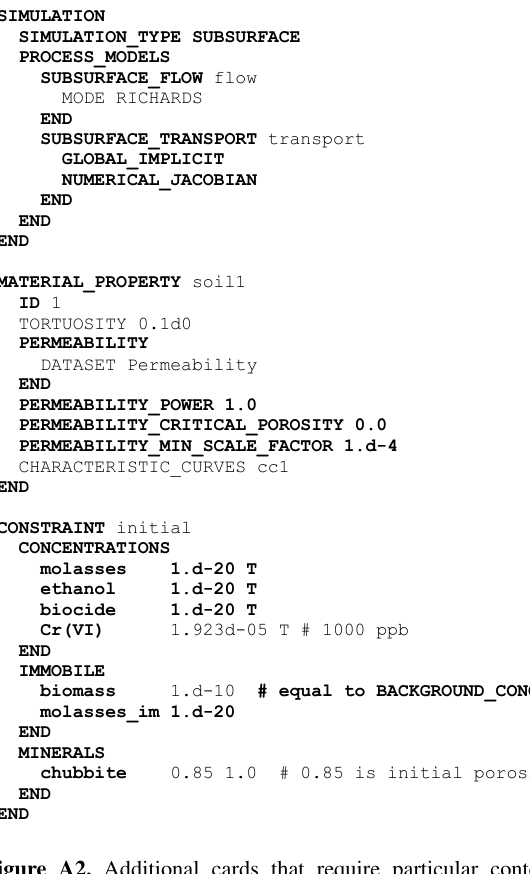
mineral is included as a surrogate for biomass and porous media volume in CHROTRAN and is updated according to Eq. (7) to track 1 − θ( x ,t) . The initial volume fraction of chubbite thus defines the initial porosity. The format of a chemistry database is discussed in more detail in the PFLO - TRAN user manual.